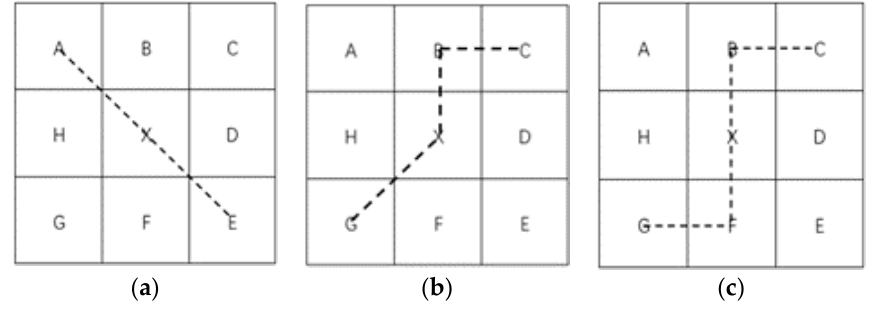
Figure 2. Trough point connection examples, the centre point X may has two ( a ) or three ( b ) or four ( c ) superior adjacent points in terms of the curvature value.